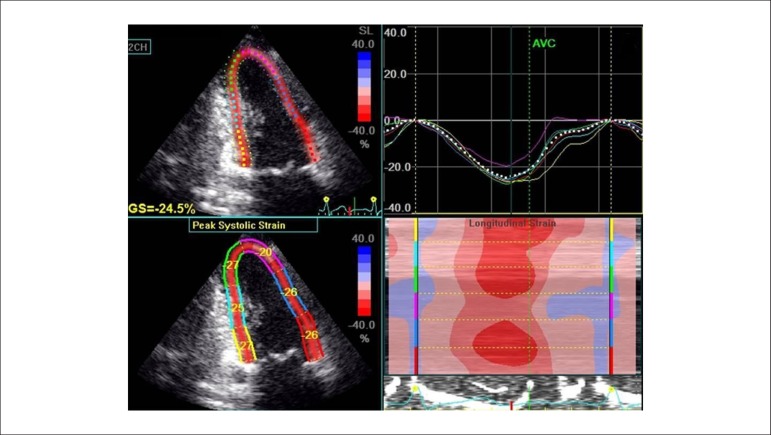
Example of global longitudinal strain analysis using speckle tracking
echocardiography. GS: global longitudinal strain; AVC: aortic valve
closure.